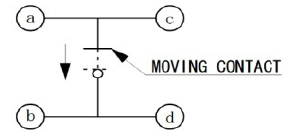
Fig. 9. Schematic diagram of push button